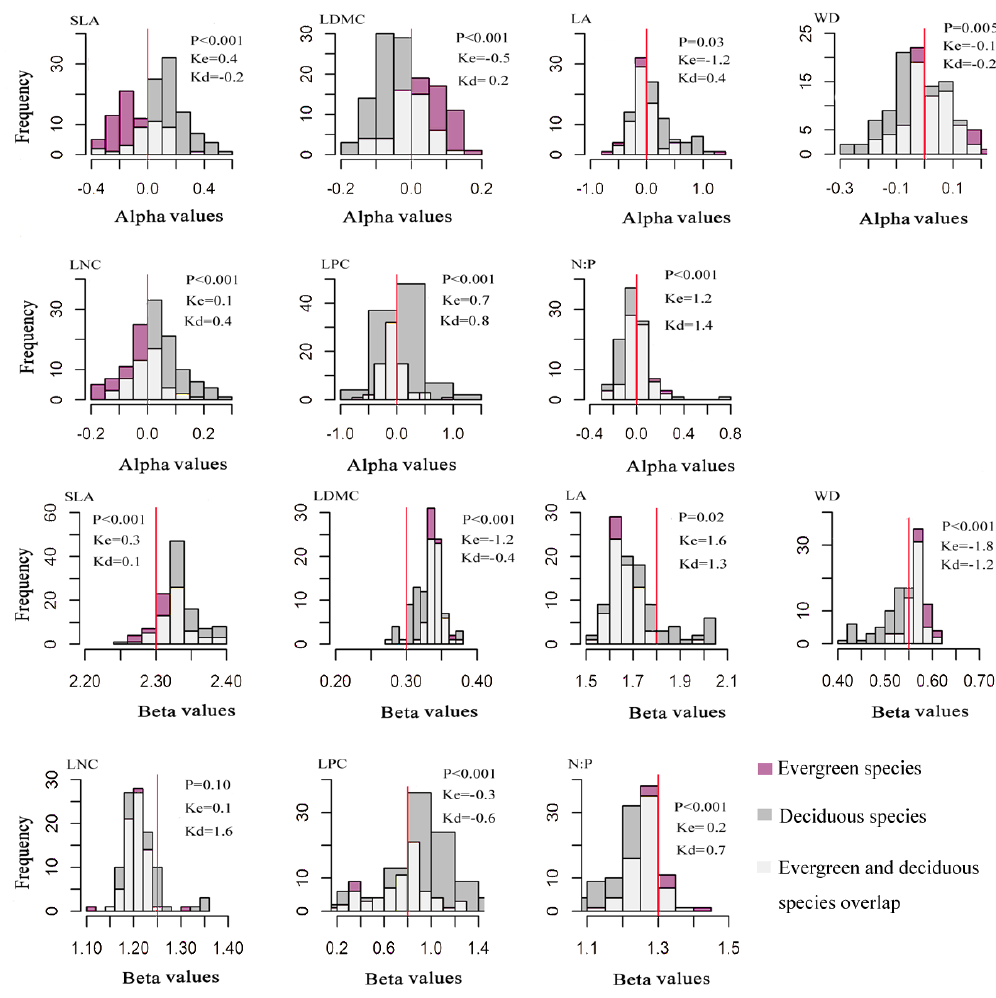
Figure 2. The distribution of frequency of alpha and beta values for evergreen and deciduous species’ seven functional traits. Note that: The abscissa was alpha values or beta values, and the ordinate was the frequency of alpha or beta values. P indicates whether the correlation is significant (* p < 0.05; ** p < 0.01; *** p < 0.001. Significant correlation). Ke indicates the degree of skewness of evergreen species. Kd indicates the degree of skewness of deciduous species. K < 0 , the distribution skews to the right of the average. K > 0, the distribution skews to the left of the average.